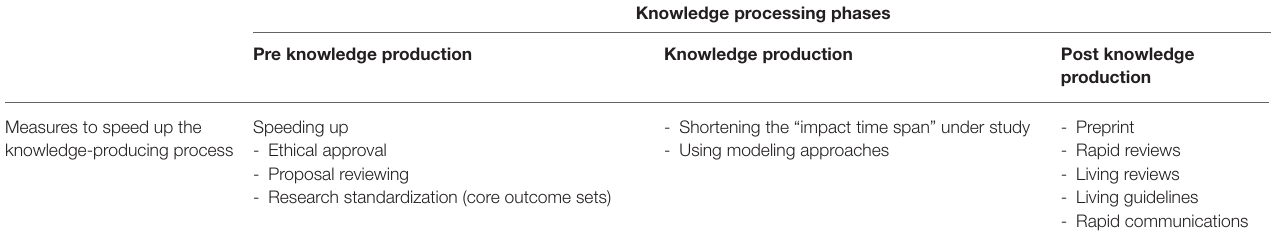
TABLE 1 | Accelerating knowledge processing: tools and measures.